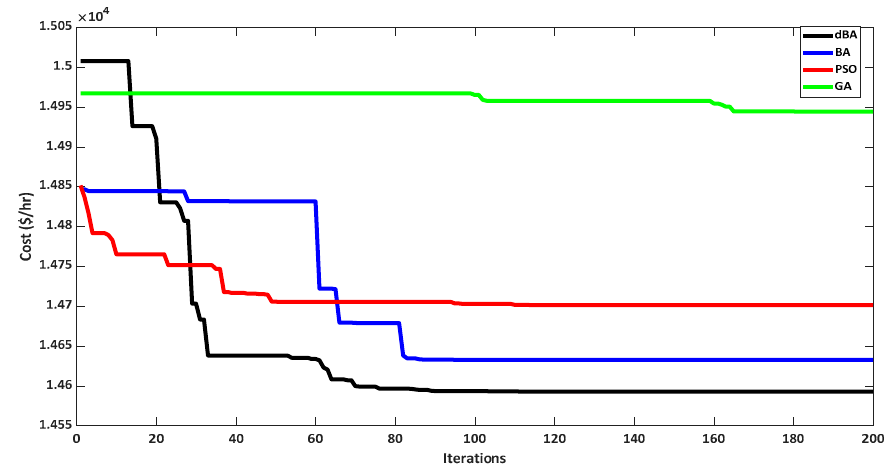
ff ect and renewables.